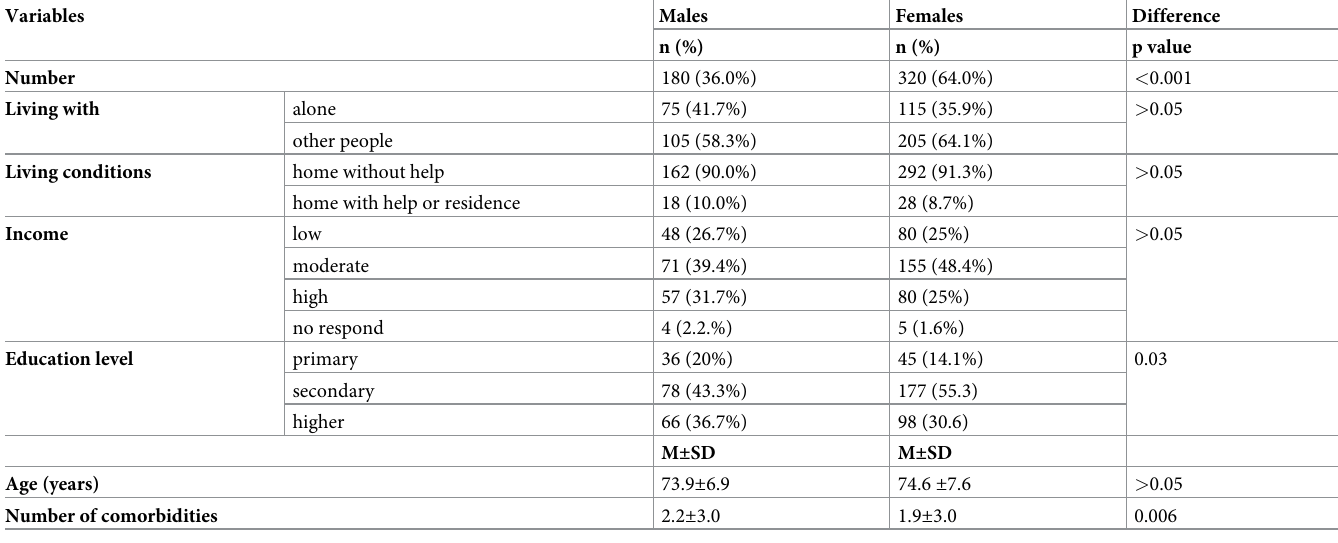
Table 1. Sociodemografic characteristic of